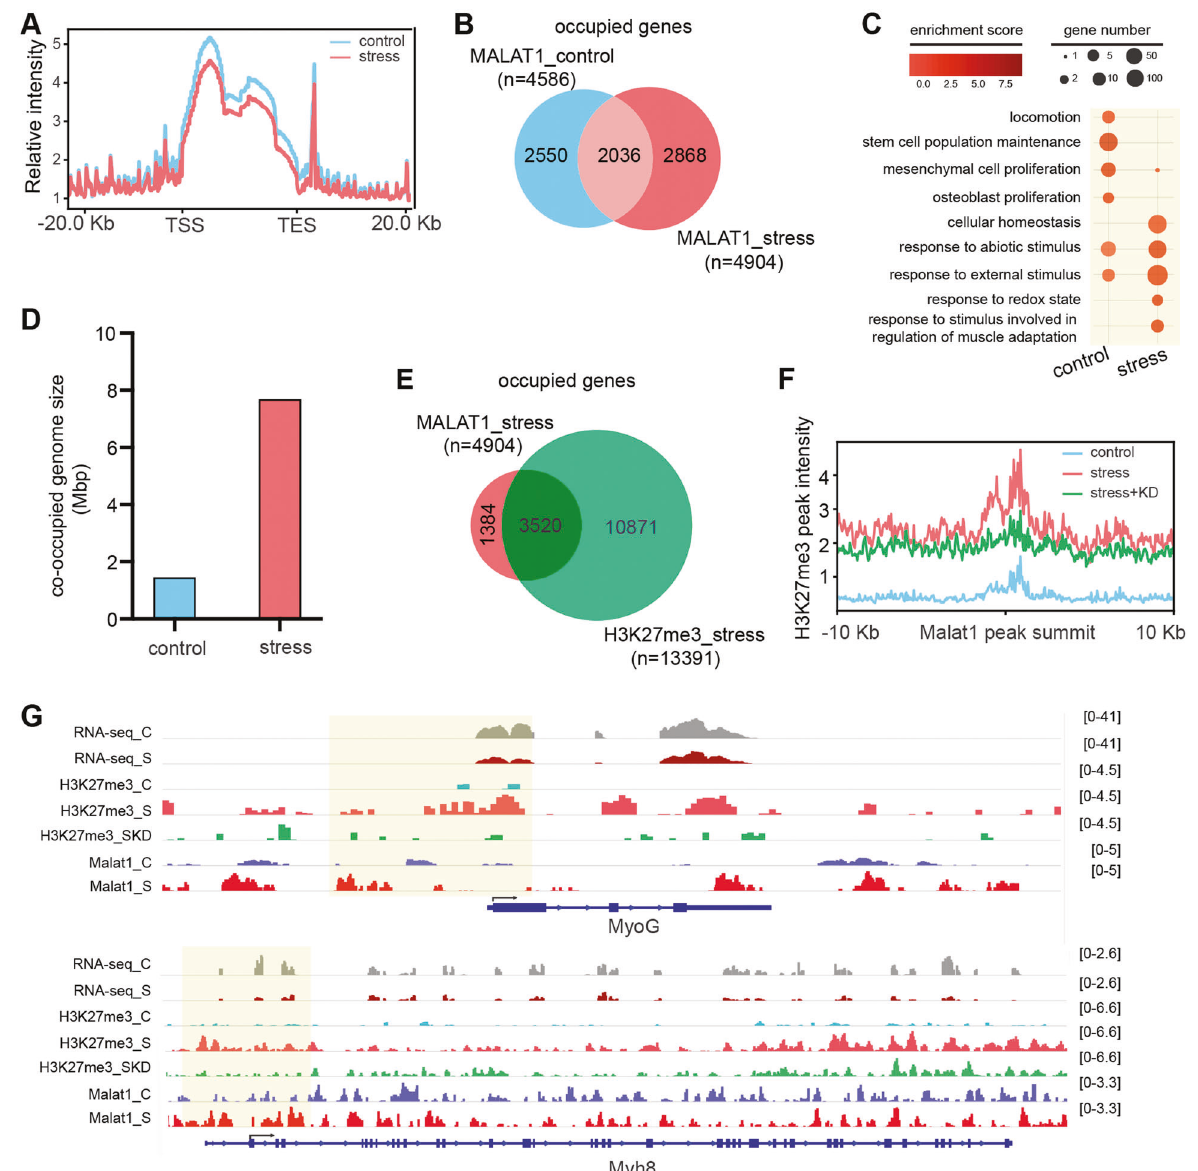
Fig. 3 Malat-1 and H3K27me3 co-occupy skeletal muscle-speci fi c genes repressed upon oxidative stress. A Metagene plot analysis of Malat1 ChIRP-seq enrichment at centered gene bodies spanned upstream/downstream ±20 kb under normal and stress conditions. B Vein diagram analysis of unique and shared genes occupied by Malat1 under normal and stress conditions. c Enriched dot plot GO analysis of genes bound by Malat1 under normal and stress conditions. Phenotypically relevant GO terms are plotted, size of dots represent number of genes and color of dots indicate relative enrichment score. D Co-occupied genomic regions size with Malat1 occupancy and H3K27me3 deposition under normal and stress conditions. e Vein diagram analysis of Malat1-bound genes possessing H3K27me3 marks under stress condition. F Normalized H3K27me3 signal intensity around (±10 kb) Malat1 ChIRP-seq occupied promoter and TSS peaks under stress condition. G IGV browser views of RNA-seq, H3K27me3 ChIP-seq, and Malat1 ChIRP-seq pro fi les around Myogenin (Myog) and Myosin Heavy Chain 8 (Myh8) genomic loci under indicated biological conditions.